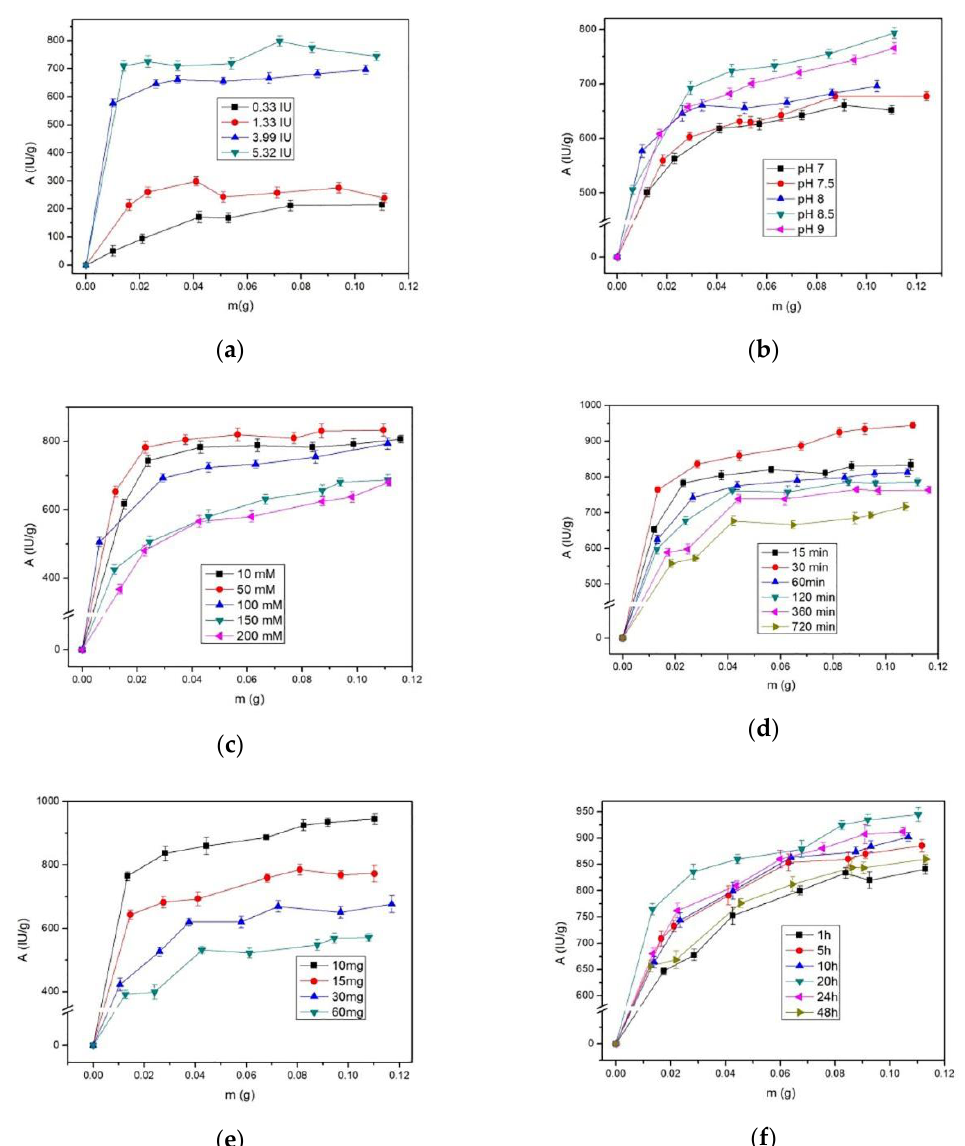
Figure 4. Effects of mass of the alcalase-alginate biocatalyst (immobilized alcalase) obtained by varying ( a ) enzyme concentration; ( b ) buffer pH; ( c ) buffer molarity; ( d ) time of EDAC treatment; ( e ) initial EDAC/microbeads mass ratio; and ( f ) time of immobilization on activity of the alcalase-alginate biocatalyst obtained from alginate microbeads produced by EE.